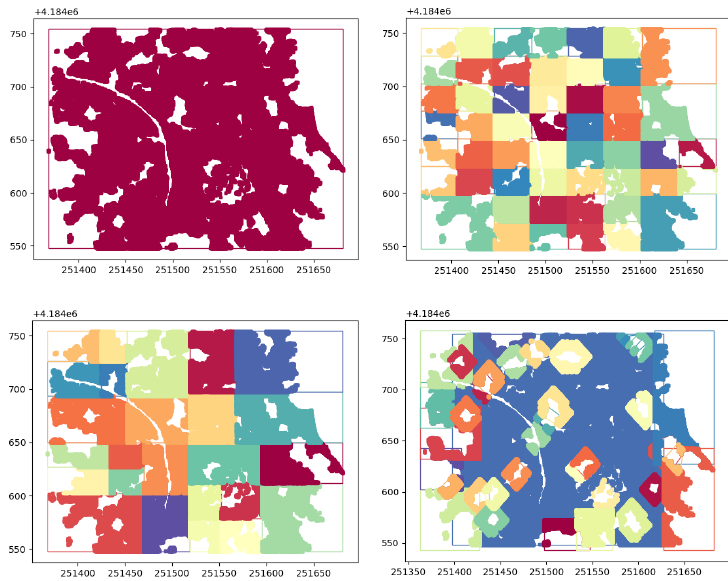
Figure 10. Partition used in ground points reclassification: ( top left ) One Plane , ( top right ) Uniform , ( bottom left ) Median and ( bottom right ) Surrounding .